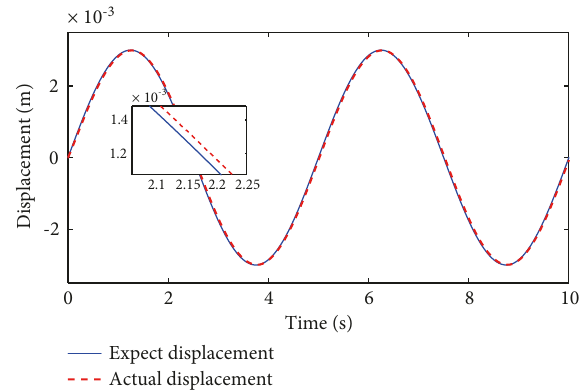
Figure 8: Sinusoidal input response curve of PID